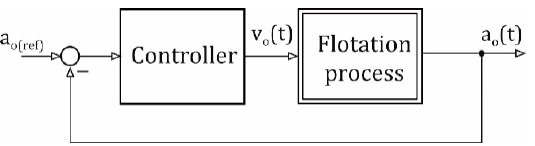
Figure 2. System for automatic stabilisation of ash content in flotation tailings.